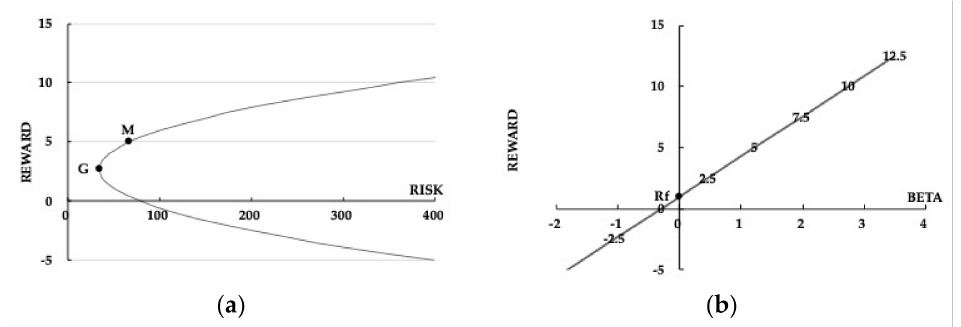
Figure 4. The trajectory of changing beta and SML. ( a ) The trajectory of changing beta; ( b ) the securities market